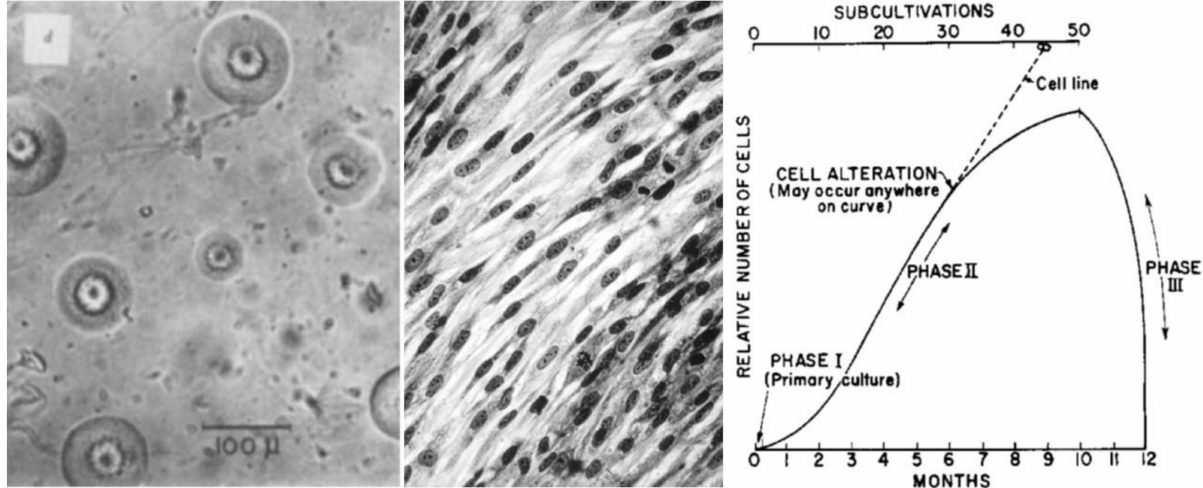
Figure 3. Mycoplasma pneumoniae is one example of a non-human cell that is capable of causing disease, i.e., coughing pneumonia, as shown by Leonard Hayflick more than 60 years ago. In those days the organism was called pleuropneumonia- like organism (PPLO); it shows a characteristic colony growth in culture (left, image taken from Hayflick and Stinebring 1960 [27]). Hayflick also established the first normal cell strain (WI-38, middle, image courtesy of Dr. Leonard Hayflick), which he distributed worldwide, thereby becoming the source of most viral vaccines. At about the same time, Leonard Hayflick and Paul Moorhead used similar cell cultures to characterize replicative cellular senescence for the first time; the “Hayflick limit” was born (right, image taken from Hayflick and Moorhead 1961